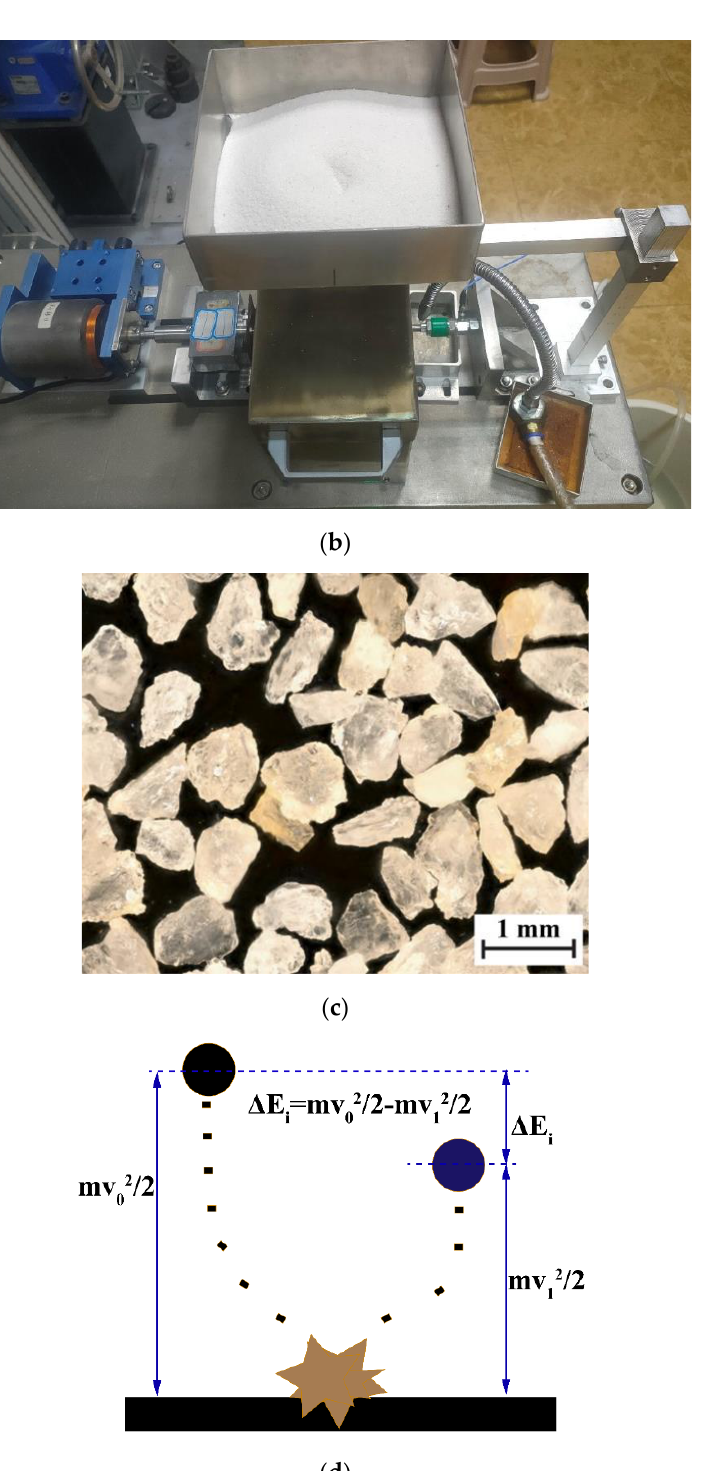
Figure 1. Schematic of high-temperature impact abrasive wear test equipment: ( a ) Equipment dia- gram; ( b ) physical drawing of equipment; ( c ) surface topography of sand; ( d ) energy conversion process.